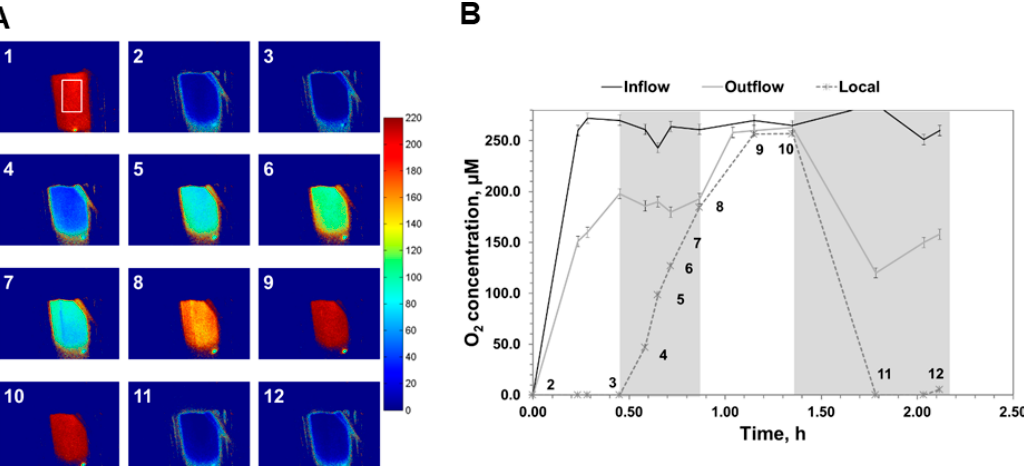
Figure 7. Results of internal and external O 2 concentration measurements during the operation of a falling-film microreactor containing immobilized D-amino acid oxidase on the microchannel walls of